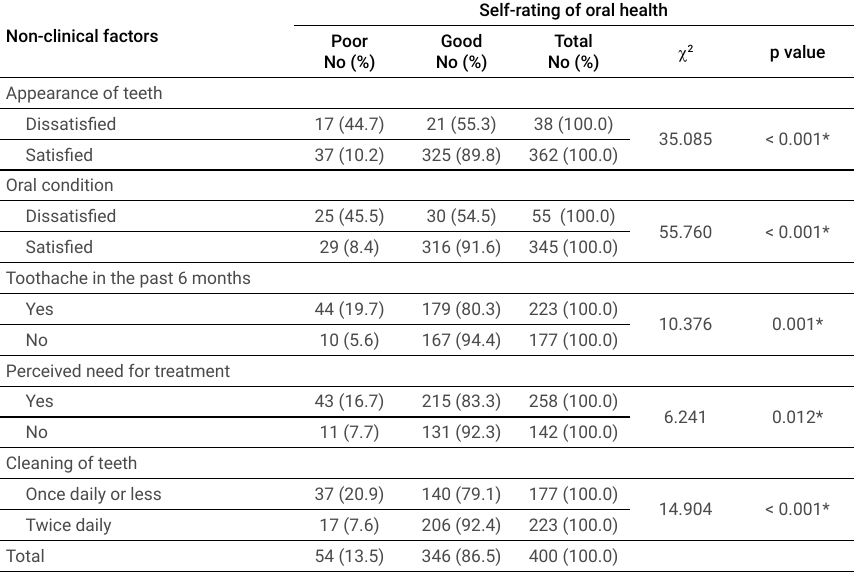
Table 1. Relationship between non-clinical factors and self-rating of oral health status of the respondents Non-clinical